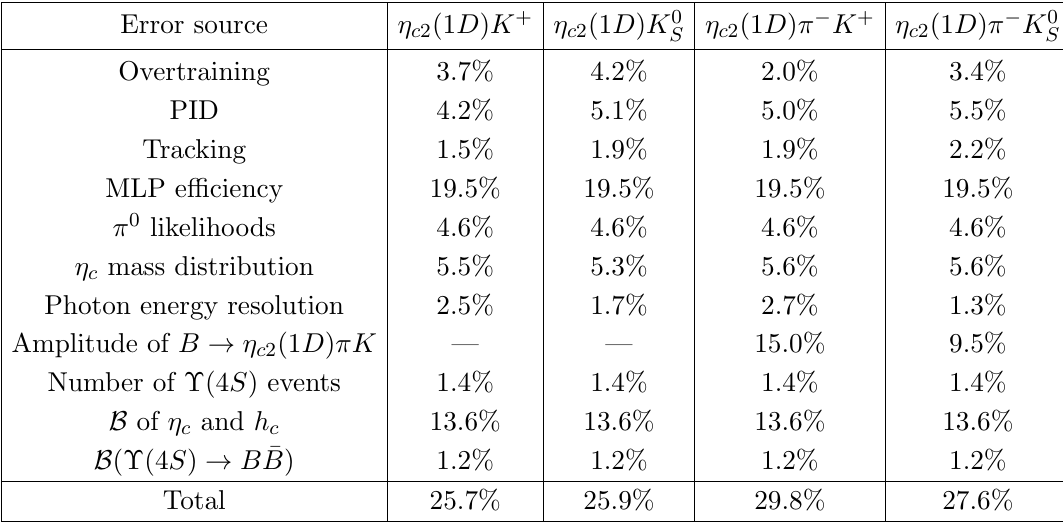
Table 7 . The systematic uncertainties of the branching-fraction